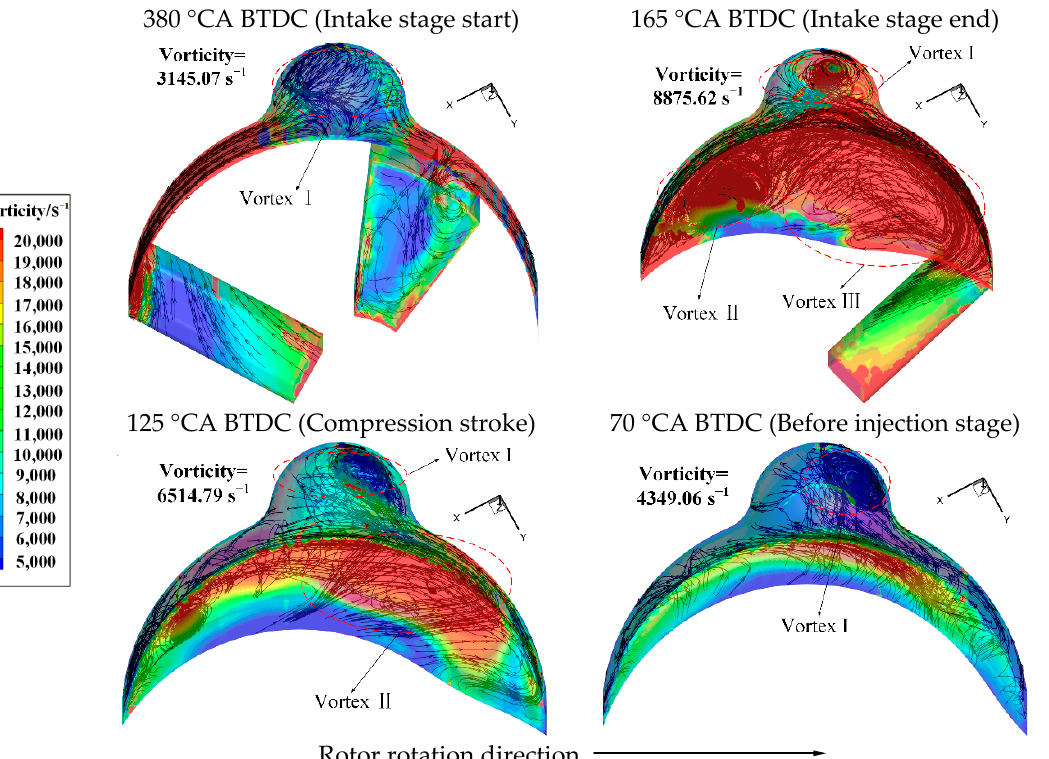
Figure 6. Flow field and vorticity changes at various stages before injection. In order to investigate the variability of the in-cylinder flow field at different injection the injection process (68 °CA BTDC), at the end of the injection (65 °CA BTDC), and during the hydrogen diffusion process (55 °CA